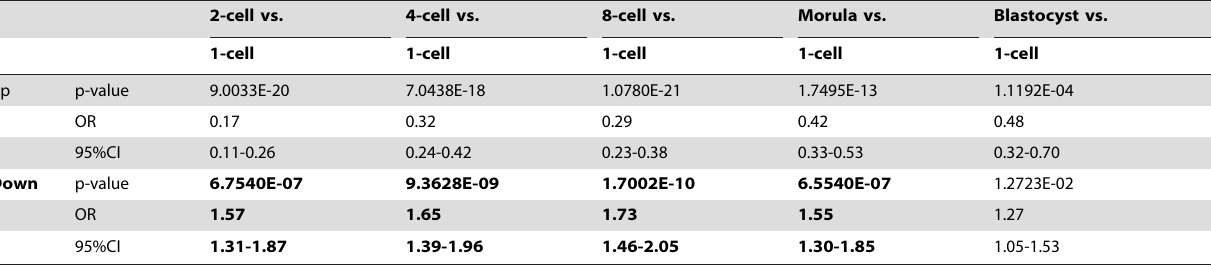
2-cell vs. 4-cell vs. 8-cell vs. Morula vs. Blastocyst vs. 1-cell 1-cell